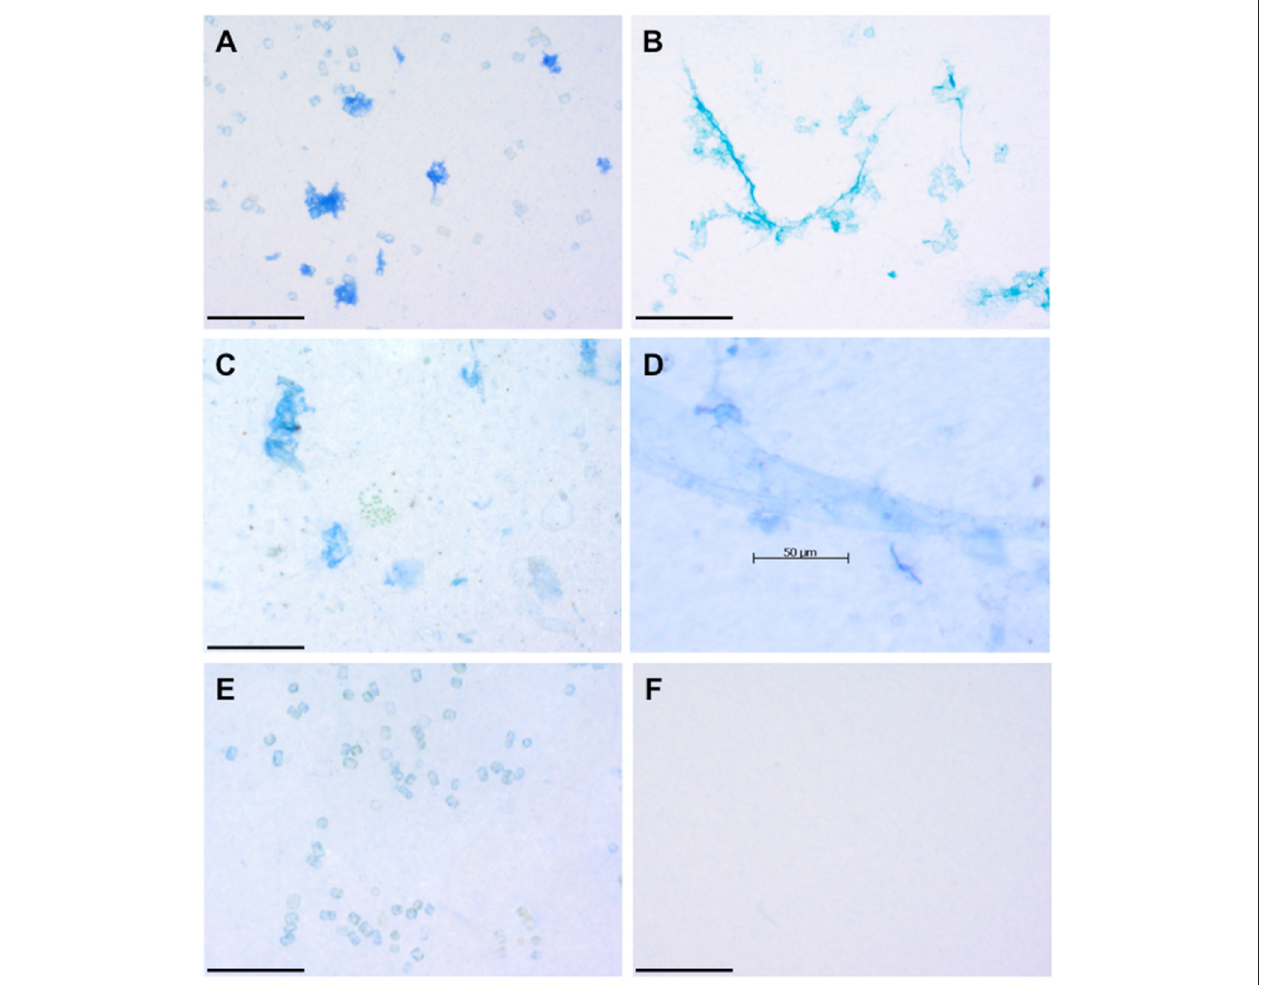
FIGURE 1 | Images of representative exopolymer particles. (A) Coomassie staining particles (CSP) in a culture of the diatom Thalassiosira weissflogii . (B) Transparent exopolymer particles (TEP) sampled at the same time in the culture of Thalassiosira weissflogii . (C) CSP and colonial green phytoplankton collected from the sea surface microlayer (SML) in the Pacific Ocean off the mouth of the Columbia River (July 2011). (D) CSP in the form of a sheet collected from the SML off the coast of Oregon, Pacific Ocean (July 2011). (E) Cell surfaces of the diatom Thalassiosira weissflogii stained with Coomassie brilliant blue. (F) Blank made during field work in the Pacific Ocean by staining the filter with Coomassie brilliant blue. Scale bars are 100 µ m ( A,B,C,E,F ) and 50 µ m (D) long. All images were captured by Daniel Thornton and have not been previously